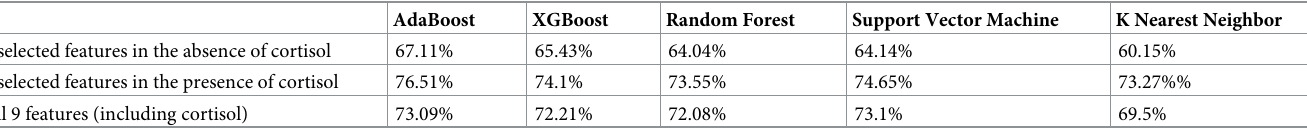
Table 3. Stress assessment results.